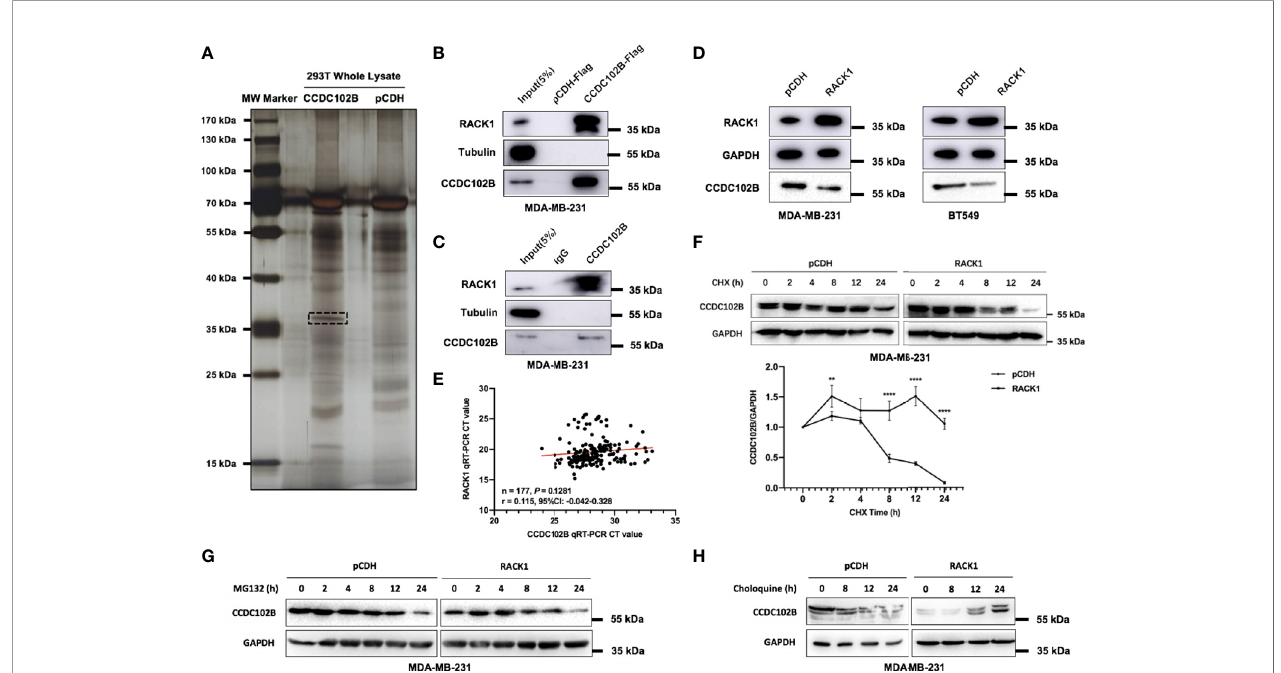
FIGURE 4 | CCDC102B interacts with RACK1. (A) Co-IP identi fi ed potential interaction partners binding to CCDC102B. (B) Immunoprecipitation experiments validated interaction between CCDC102B and RACK1 using MDA-MB-231 stably overexpressing CCDC102B-Flag. (C) Immunoprecipitation experiments to validate endogenous interaction between CCDC102B and RACK1. (D) Overexpression of RACK1 signi fi cantly decreased the expression level of CCDC102B in both MDA- MB-231 cells and BT549 cells. (E) Gene expression pro fi le correlation between CCDC102B and RACK1 using qRT-PCR analysis in 177 breast cancer patients. (Spearman r) (F) Overexpression RACK1 decreased the stability of CCDC102B and shortened the half-life of CCDC102B. Quantitative analysis was analyzed by ImageJ. (** P = 0.0010; **** P < 0.0001) n=3, biological replicates. (G) MG132 treatment did not signi fi cantly alter the protein levels of CCDC102B. (H) Choloquine treatment resulted in an accumulation of CCDC102B in a time-dependent